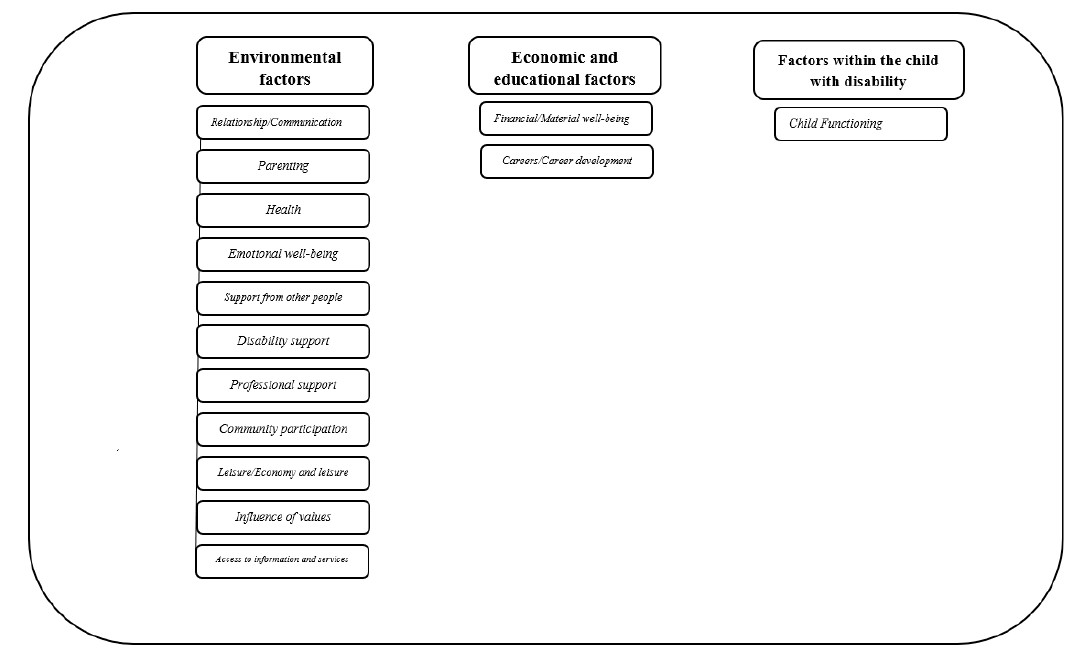
Figure 4. Overarching categories and domains used in the FQoL scales.